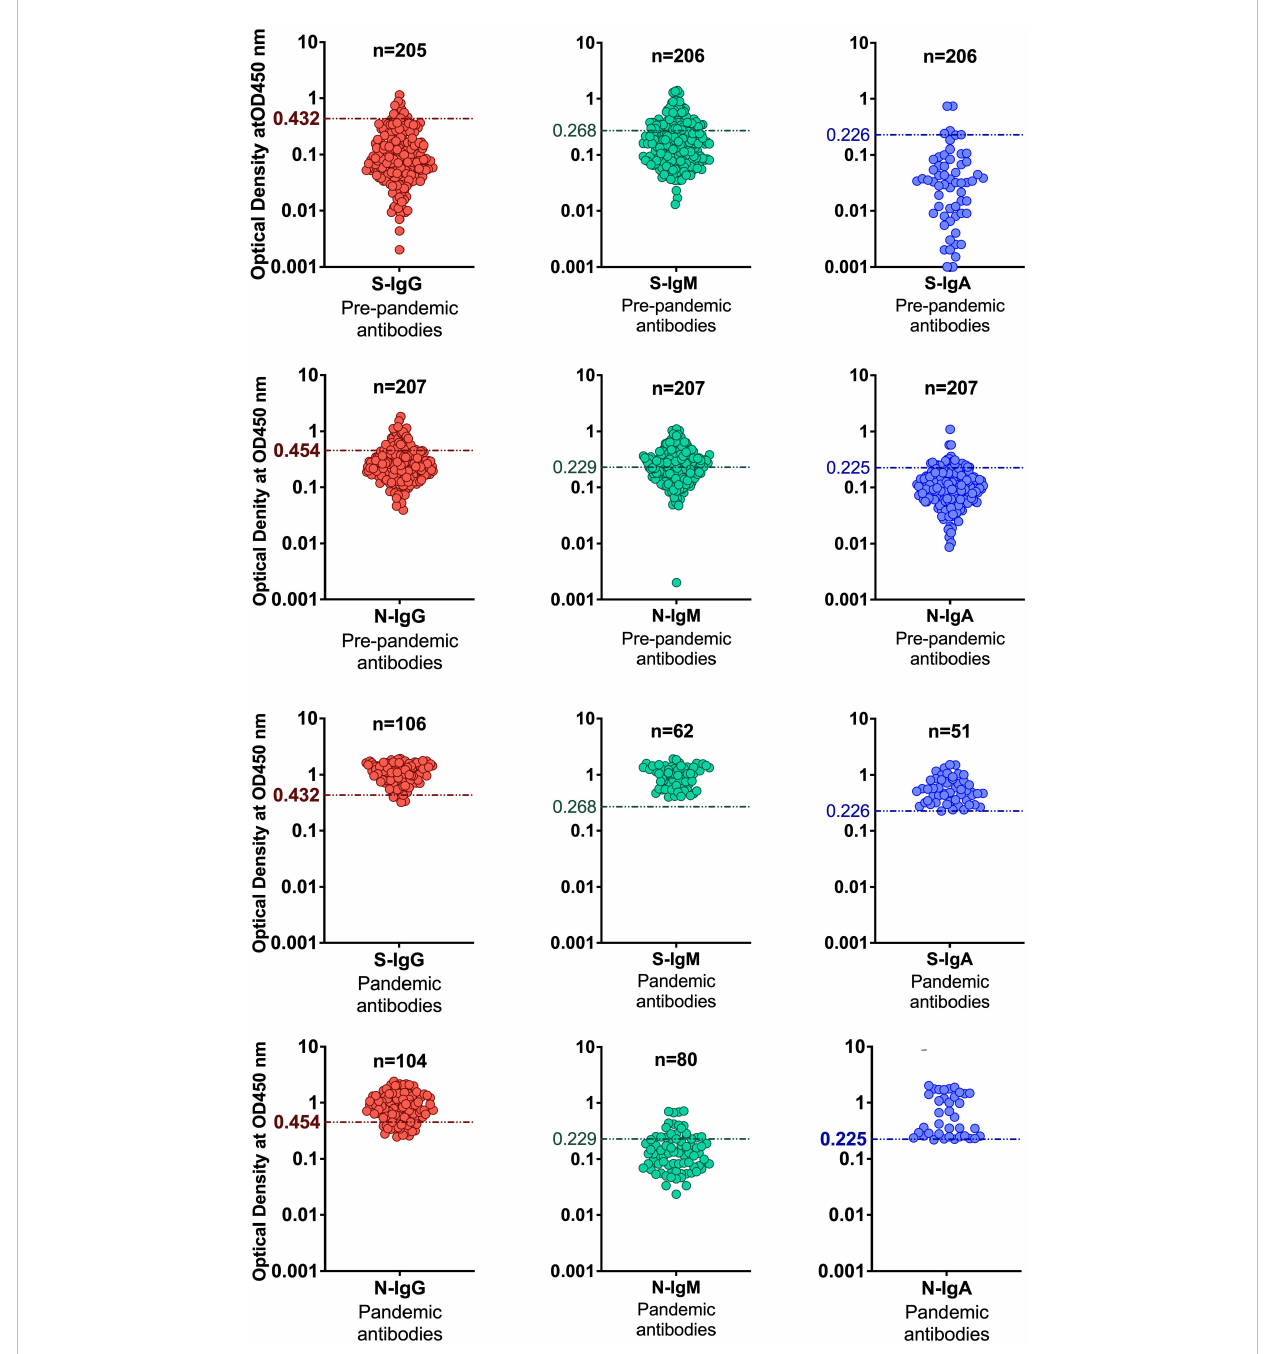
FIGURE 2 Distinguishing serostatus using ROC-derived cut-offs. The fi gure shows categorization of positive and negative specimens based on cut-off values determined by the ROC curve analysis